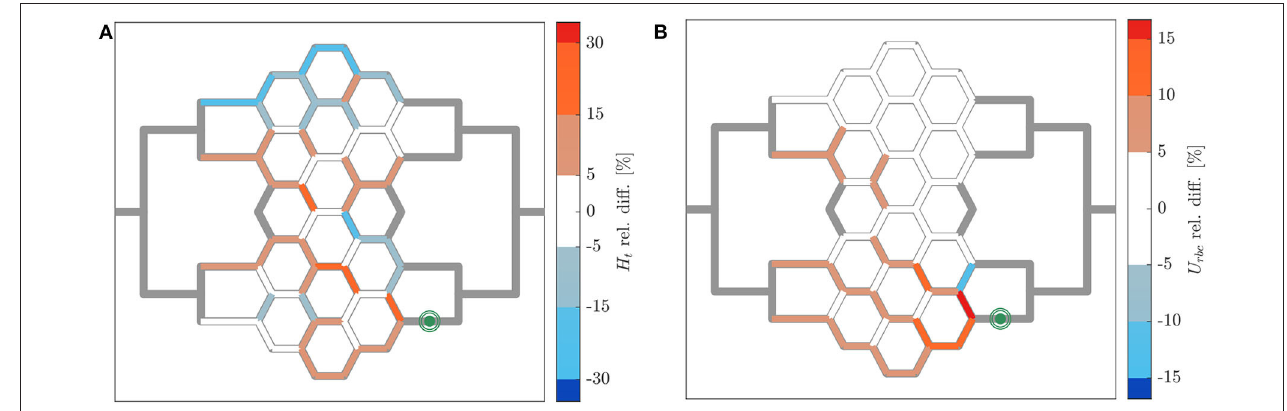
FIGURE 6 | Hematocrit and RBC velocity relative difference for pericyte activation. Relative hematocrit (A) and RBC velocity (B) difference for individual micro-channels of the honeycomb network between the inflation of the pressure chamber ( 1 P p 0 bar ). The green symbol indicates the activated micro-channel. Flow direction is from left to =